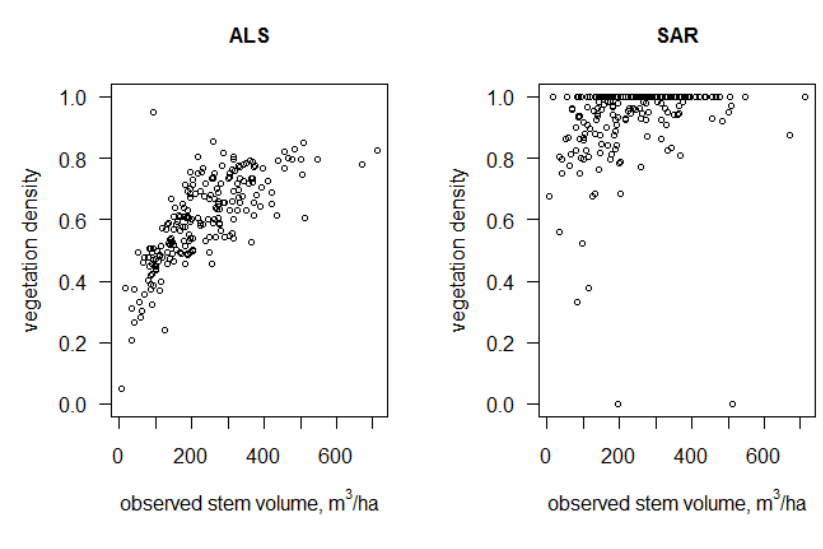
Figure 4. Vegetation density based on ALS and SAR related to observed stem volume at the plot level.